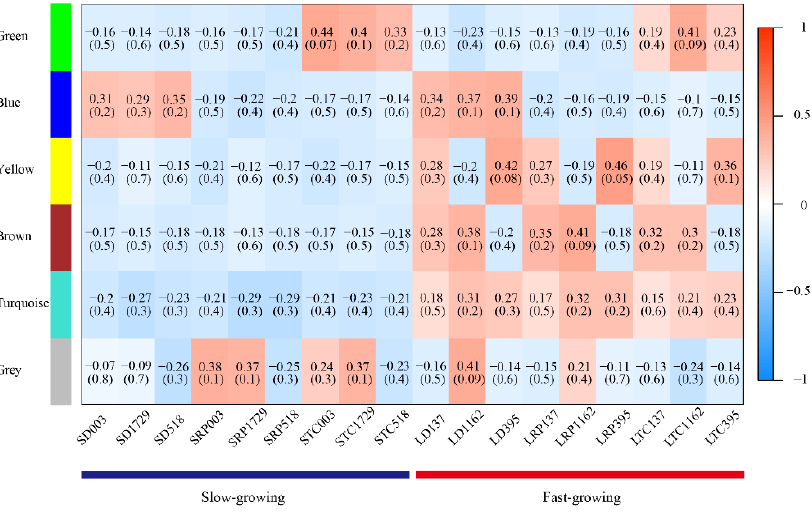
Figure 3. Relationship between module and sample. Each row represents a module, and each column represents the antler growth center tissue of an individual. The correlation increases with a redder color. The correlation analysis among samples and modules shows that yellow, brown and turquoise modules were closely related to antler growth rate.